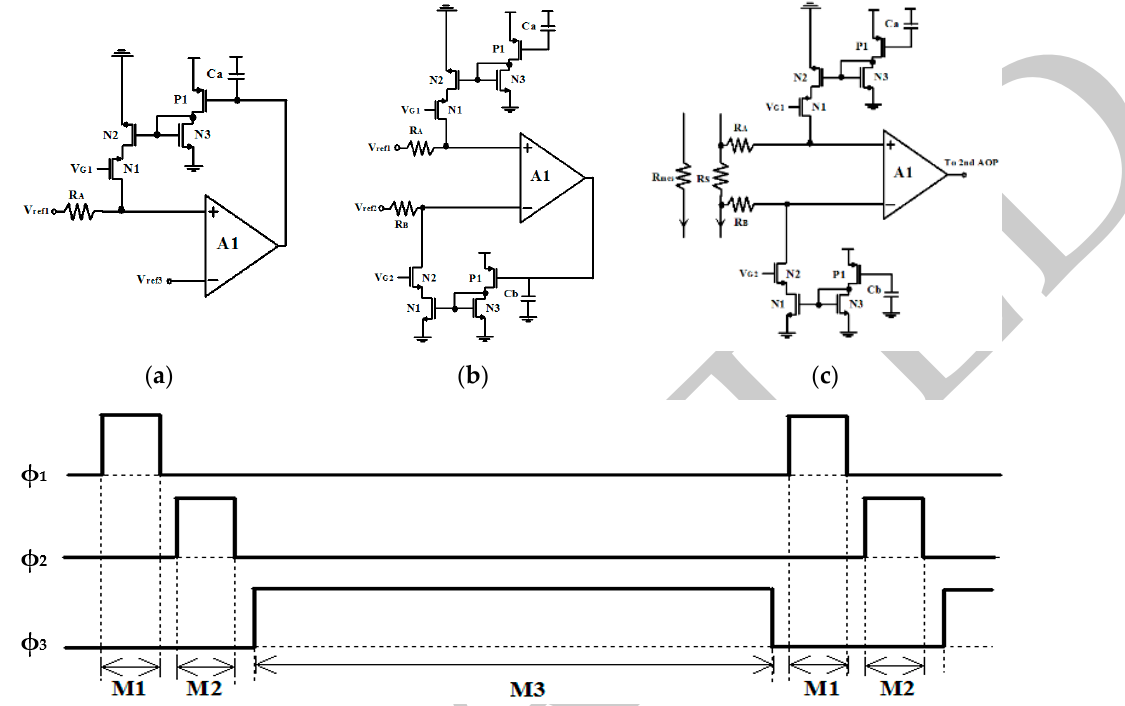
Figure 4. Equivalent circuits for the three operation modes M1, M2, and M3 (( a )–( c), respectively) with their selected digital signals ϕ 1 , ϕ 2 , and ϕ 3 .